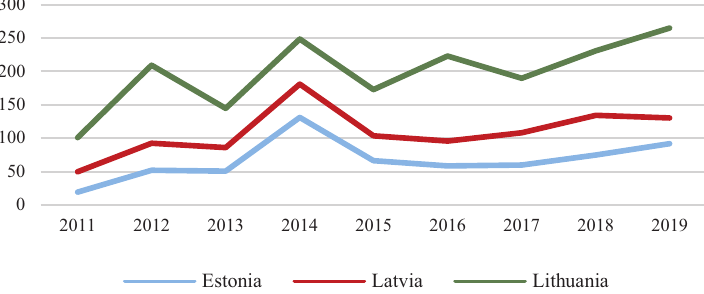
Figure 2. Export to the United Arab Emirates (source: created by